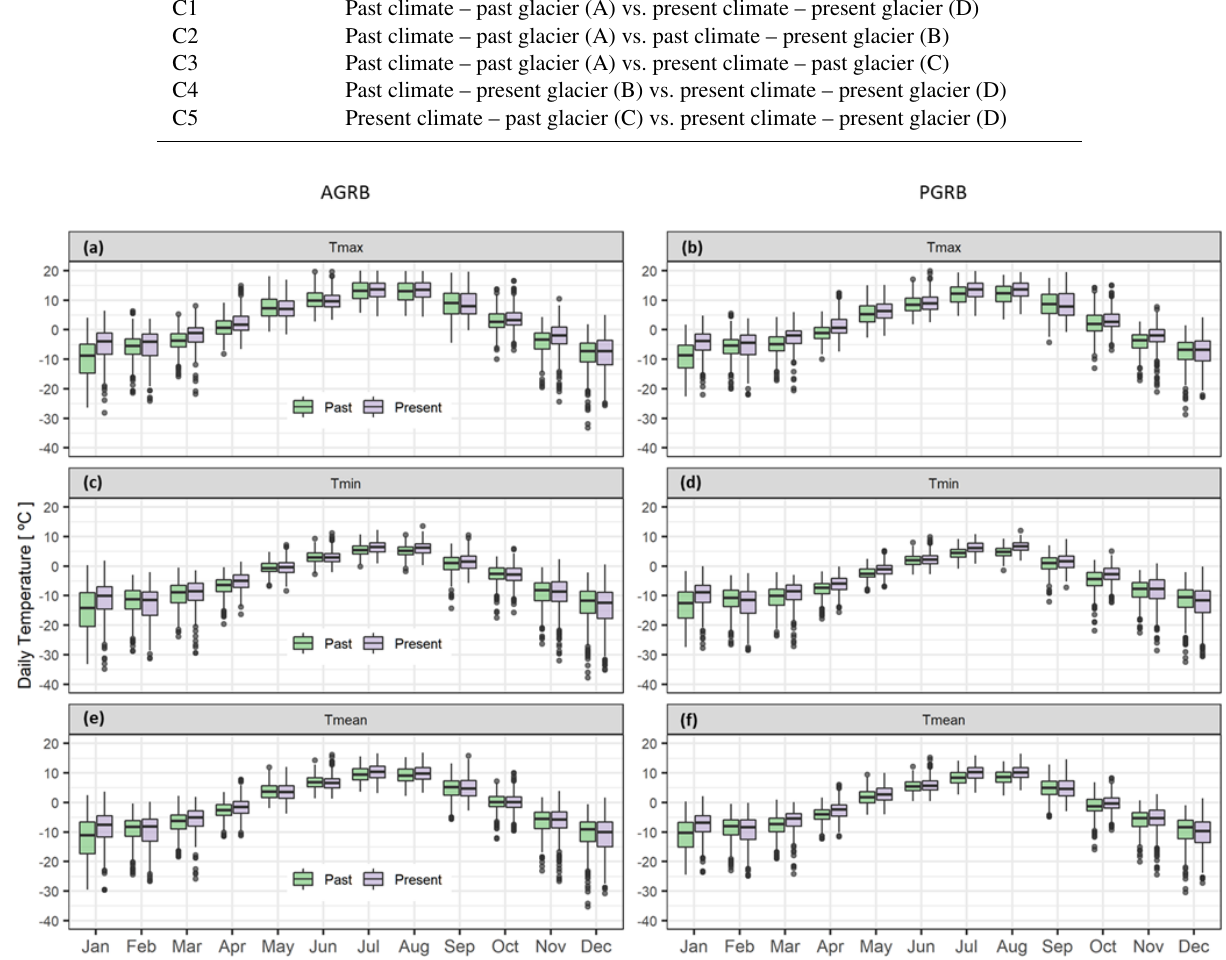
Figure 2. Monthly means of daily maximum (a,b) , minimum (c,d) , and mean (e,f) temperature comparison between two periods, i.e.,